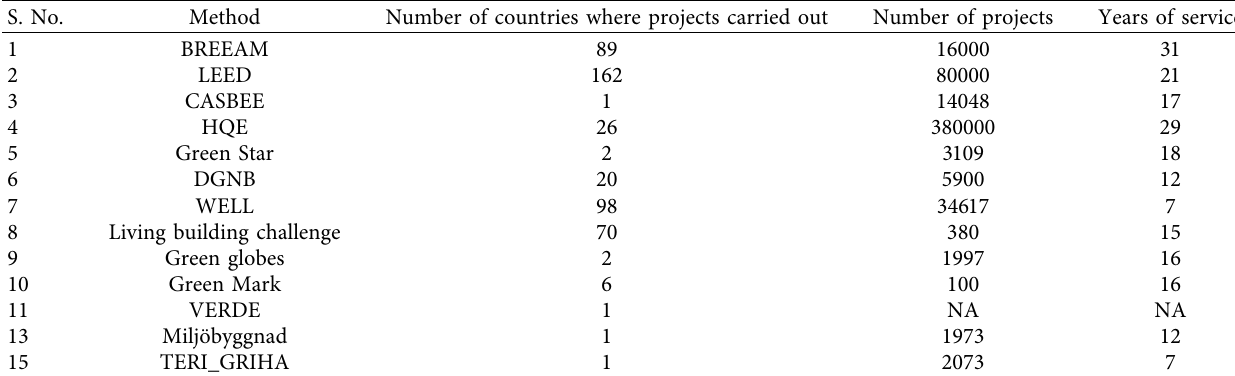
Table 1: List of major environmental building assessment methods.